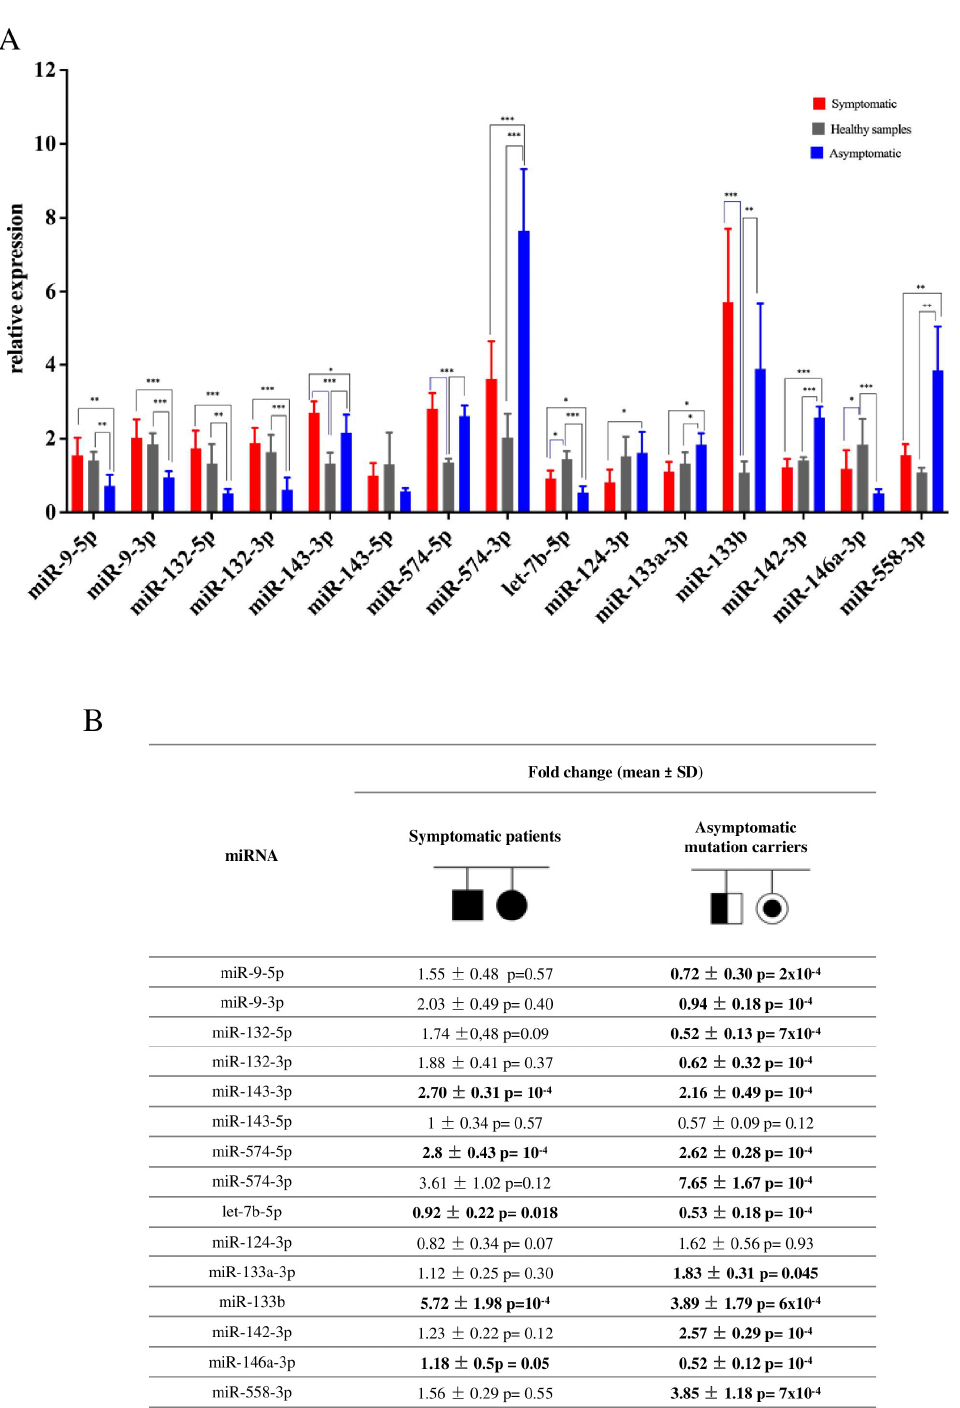
Figure 1. ( A ) miRNA dysregulation in plasma of ALS family subjects with TARDBP -G376D mutation compared to healthy control samples. *: p < 0.05: **: p < 0.01. ***: p < 0.001; ( B ) relative miRNA expression in a TARDBP -G376G family compared to healthy family members. miR = miRNA; statistically significant differences are highlighted in bold. SD = standard deviation.